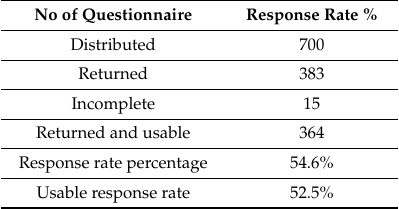
Table 4. Response rate of questionnaires.